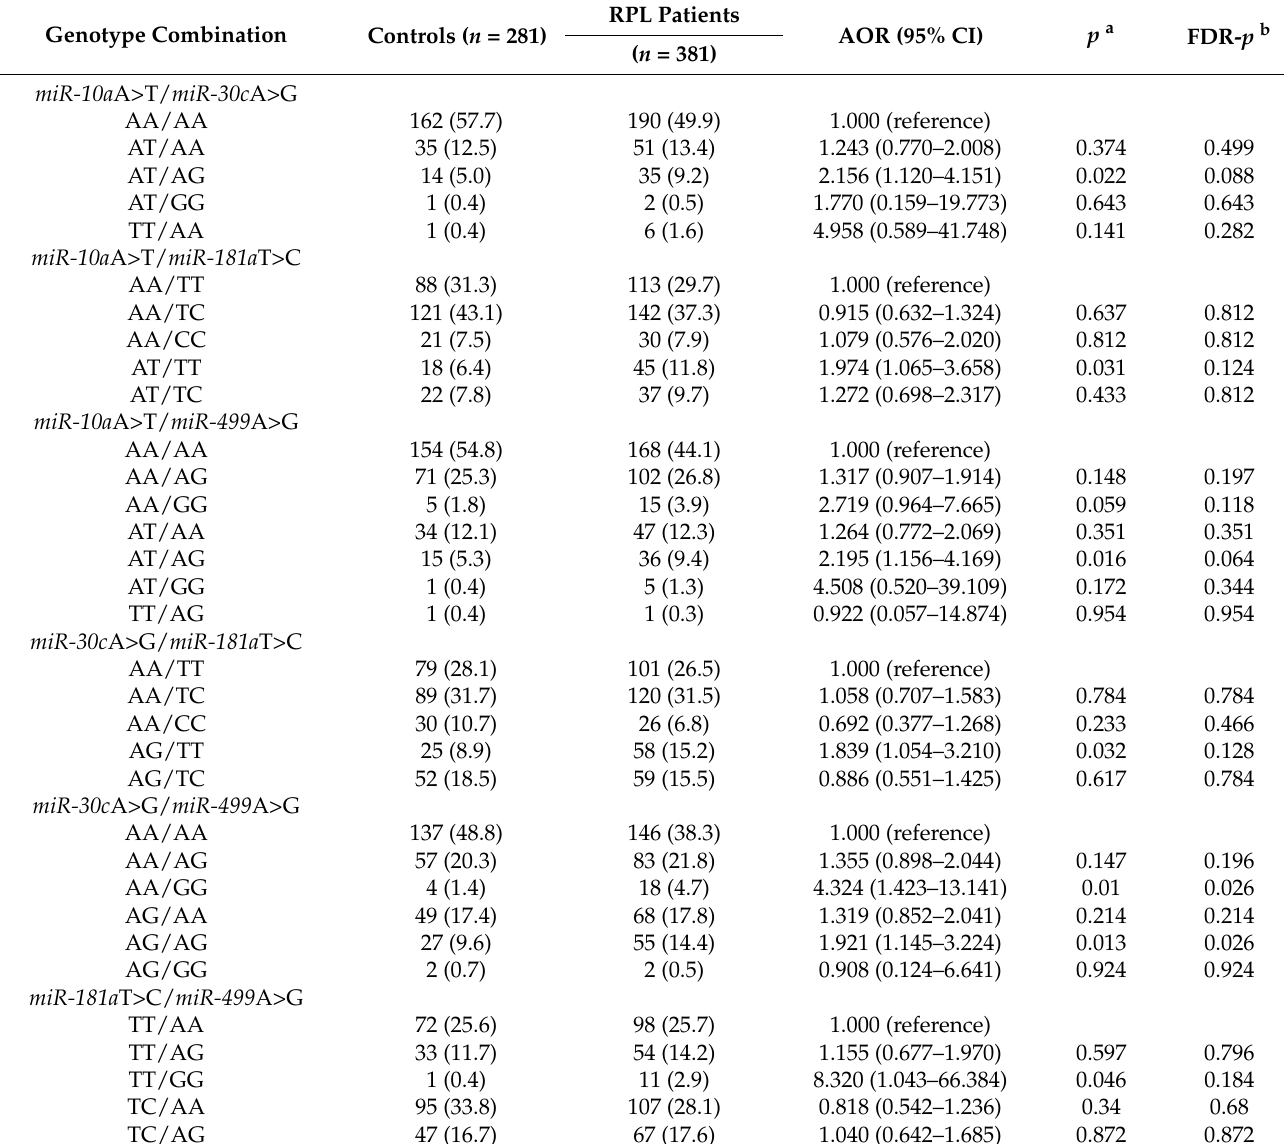
Table 4. Combination analysis of miRNA polymorphisms between recurrent pregnancy loss patients and control